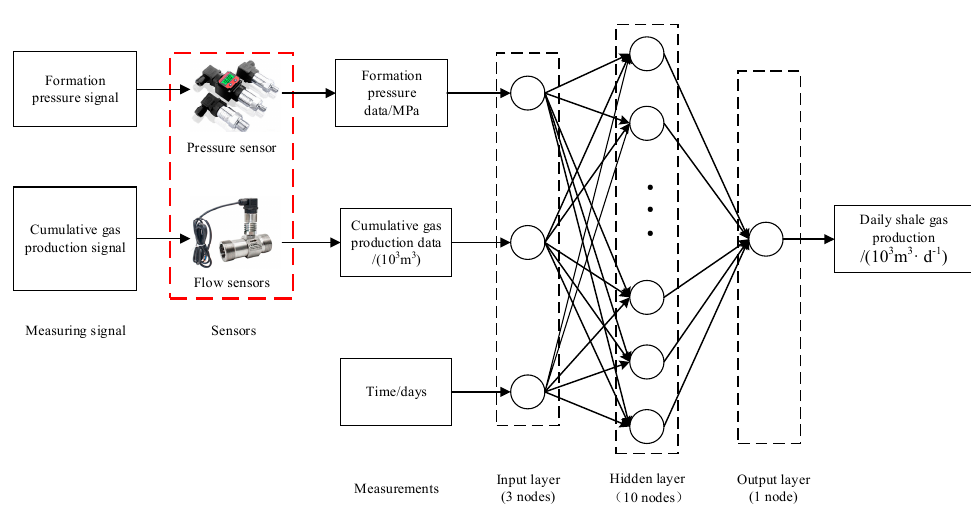
Figure 13. Prediction model of oilfield development index based on ANN.